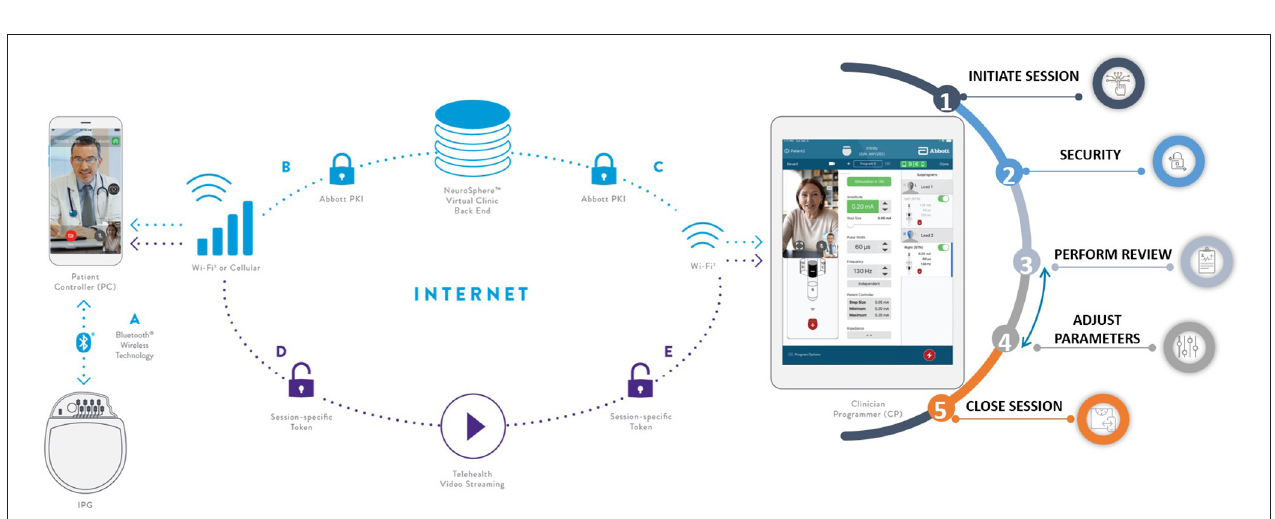
FIGURE 5 | Abbott’s NeuroSphere TM Virtual Clinic. The software platform enables the remote DBS clinician to not only investigate the patient’s IPG and run system checks remotely but also to make stimulation therapy changes over the internet.